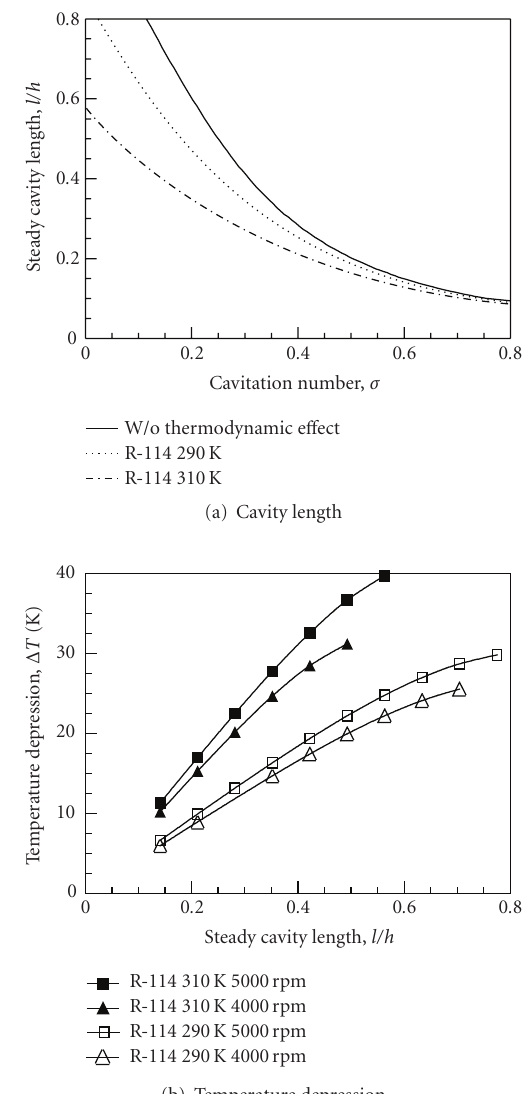
OnsetofalternatebladecavitationWater Endofrotatingcavitation Onsetofrotatingcavitation Alternateblade cavitation